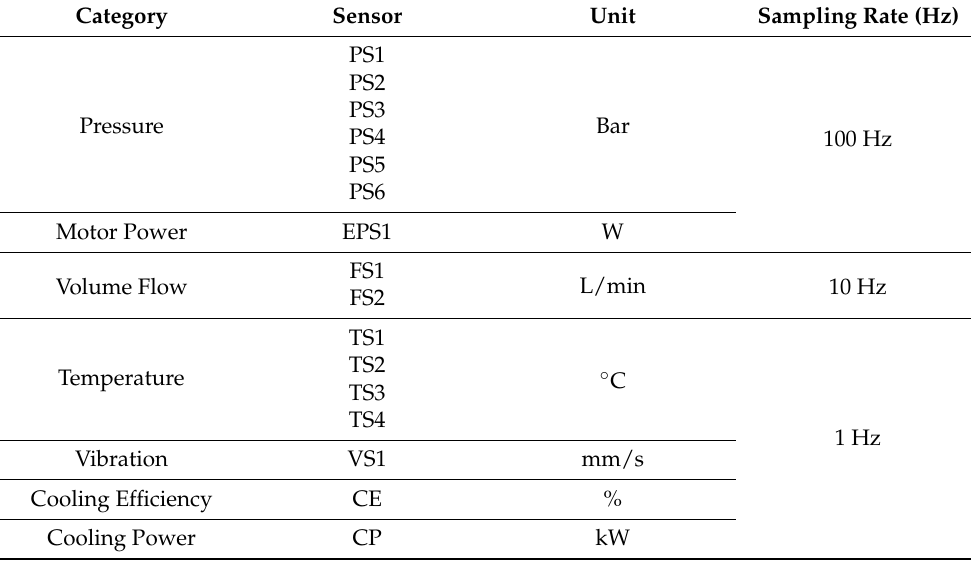
Table 2. Sensor data measured each minute in the hydraulic